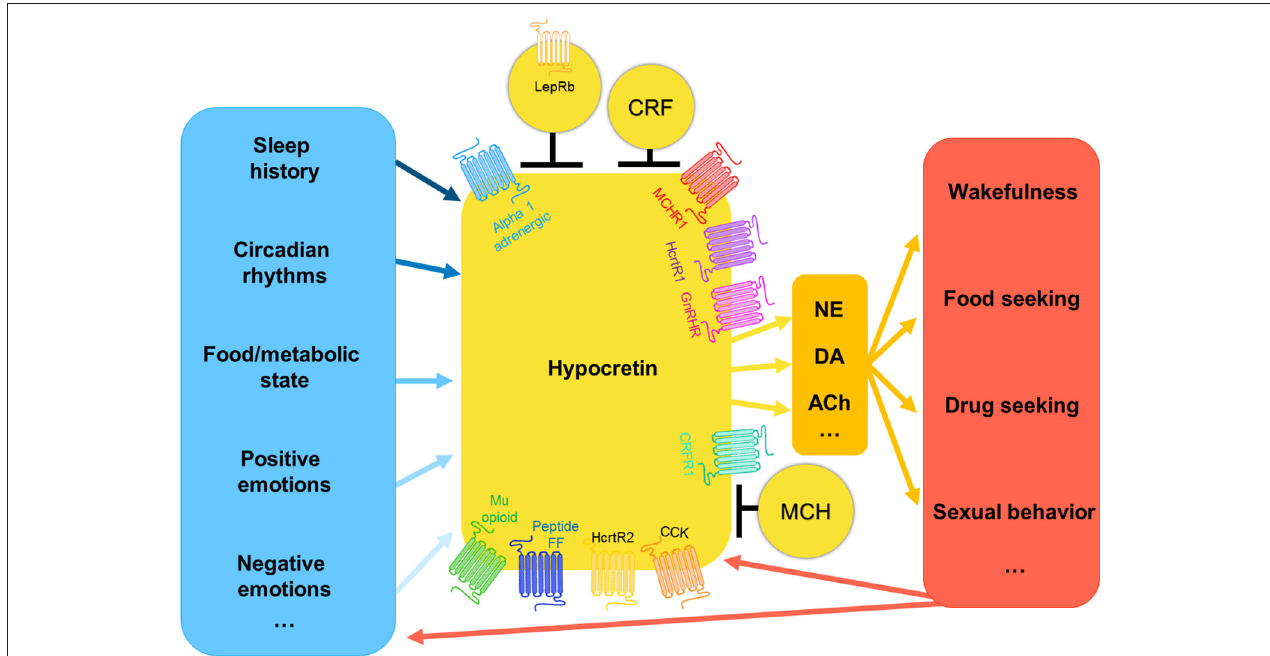
FIGURE 1 | The hypocretin system: inputs and outputs. Hypocretin neurons receive information regarding nutritional state, emotional state, and environmental cues regarding temperature, time of day, and recent sleep history, the weight that these inputs have is very likely variable and interrelated. Hypocretin-expressing neurons are very heterogeneous, they are known to co-express numerous other genes. Additionally, hypocretin-expressing neurons are modulated by the activity of surrounding neuron populations present in the lateral hypothalamus, including melanin-concentrating hormone, leptin receptor-expressing neurons, and corticotropin releasing factor neurons. Hypocretin neurons project to many neuron populations throughout the brain, including norepinephrine, dopaminergic, and cholinergic neurons. It is via these pathways that the hypocretin system modulates the wide range of outputs related to arousal and motivated behavior. In turn, the consequences of these behaviors go on to inform the hypocretin system as to the newly updated status of the animal, and thus determine the next hypocretin-driven behavioral